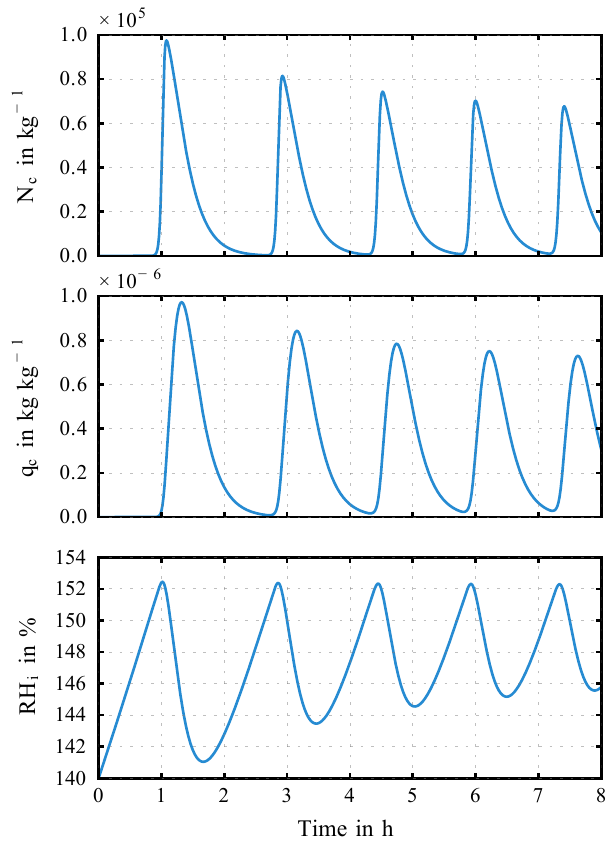
Figure 2. A scenario in state 2 (limit cycle regime) is shown at w = 0 . 02ms − 1 and T = 210K. Nucleation events occur as pulses; thus, an undamped oscillation evolves, which describes a limit cycle in phase space (see Fig.